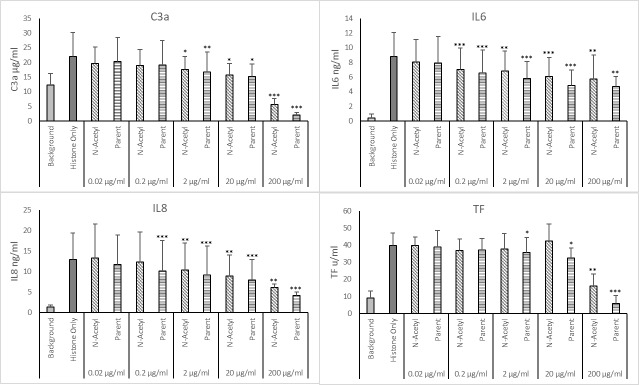
Dose effect of heparin and N-acetyl heparin on attenuating histone induced inflammatory responses in whole blood.Histones, 50μg/ml, and increasing concentrations of parent heparin and n-acetyl-heparin were added to whole blood and incubated for 6 hours. Released C3a, IL-6 and IL-8 were measured in plasma and tissue factor was measured from the cellular component. Analysis of data was carried out using Dunnett’s multiple comparison with no heparin (histones only) as the control sample, * = p < 0.05, ** = p < 0.01, *** p <0.001. Error bars = standard deviation of the average from 6 donors.